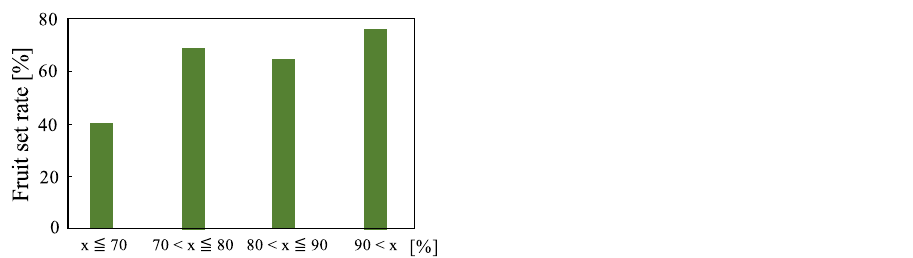
Figure 11. Threshold of the accuracy rate obtained from fruiting